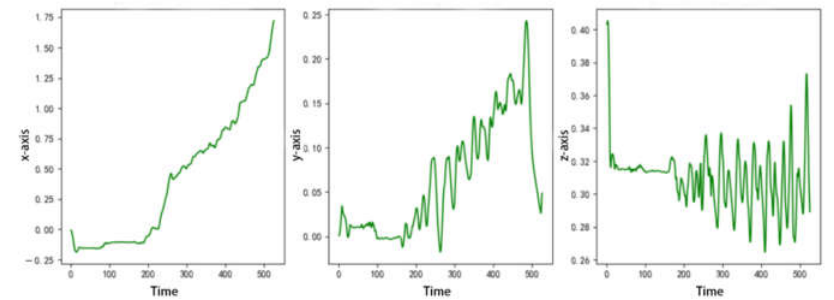
Figure 10. Motion trajectory of quadruped robot using needs learning algorithm. The y -axis represents the left–right offset of the quadruped robot. The maximum left– right offset is 25 mm, which indicates that the quadruped robot can roughly keep walking in a straight line; the z -axis represents that the quadruped robot can pitch up and down at a maximum of 40 mm. At this time, the center of mass of the body does not float up and down relative to the height of the ground, indicating that the quadruped robot moves smoothly. The negative direction of the x -axis represents the forward direction of the quadruped robot. It has walked for 8 motion cycles in 3 s, moving forward a total of 175 mm, and the walking speed is about 0.0583 m/s. The small error is due to the certain slid- ing with the ground during the walking process of the quadruped robot. The motion speed is close to the theoretical speed, and the curve is smooth, which shows that the quadruped robot can move forward harmoniously and smoothly. The gait of quadruped robot generated by needs learning algorithm is shown in Video S1, which is supplied in Supplementary Materials.